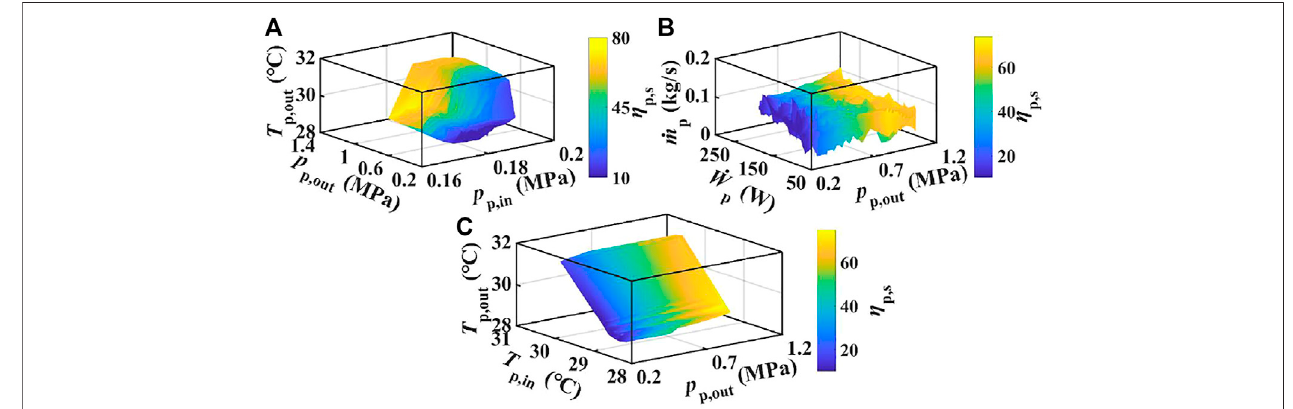
FIGURE 9 | Optimal boundaries of operating parameters at 870 r/min.